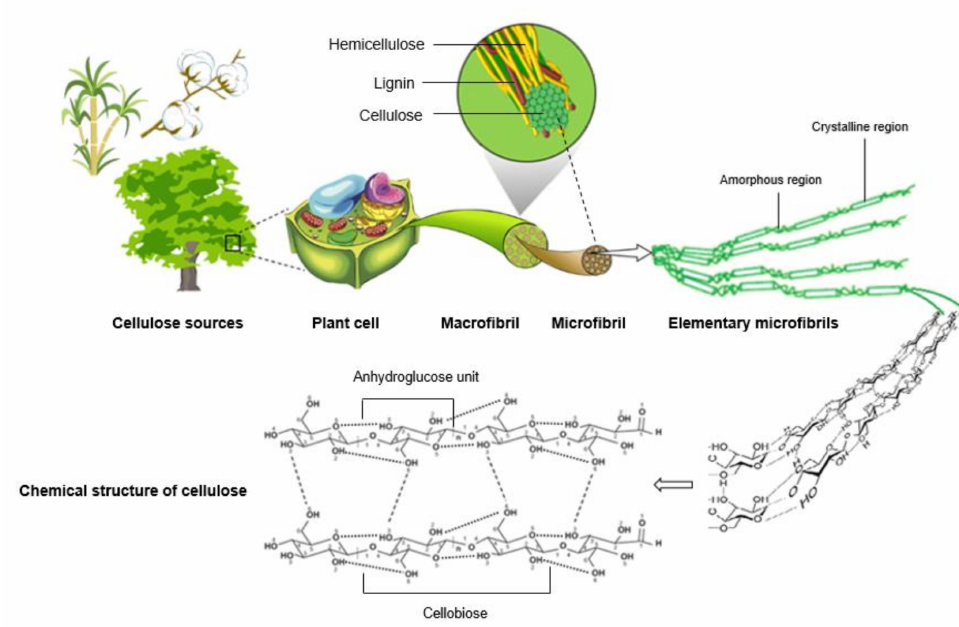
Figure 3. Schematic representation of the hierarchical structure of cellulose fibers and the chemical structure of